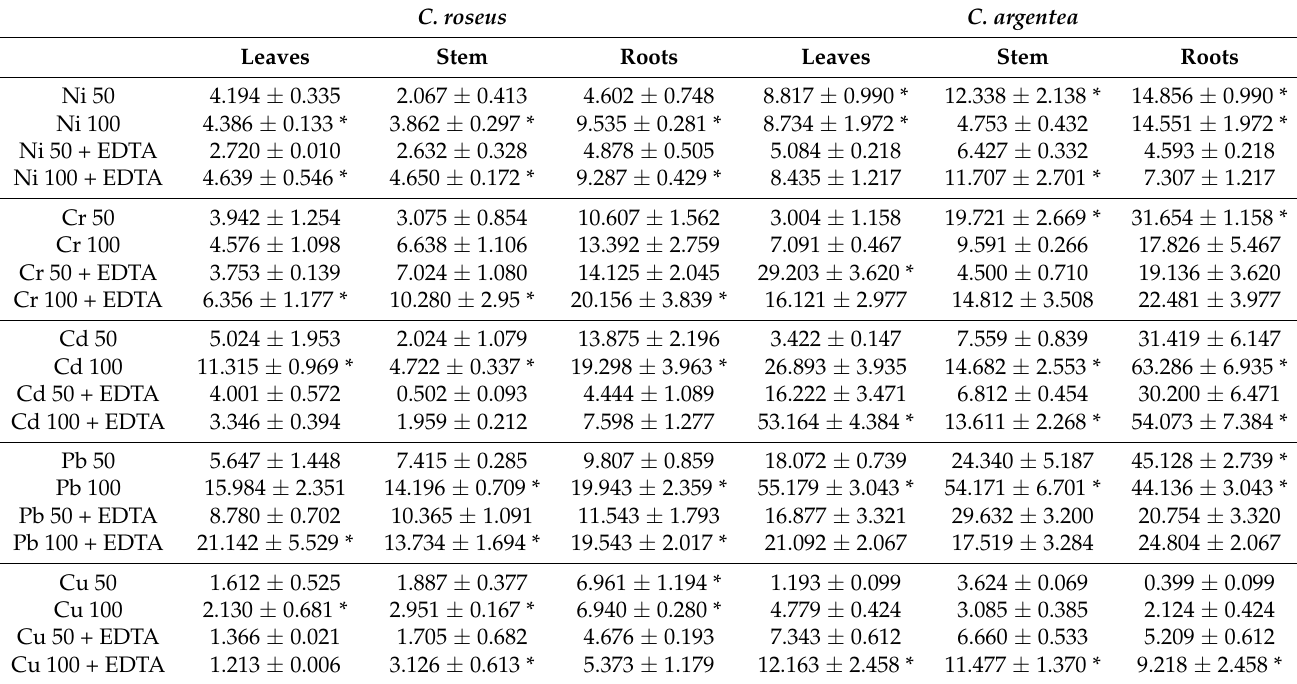
Table 4. Cumulative metal uptake in µ g per plant compartment at the time of